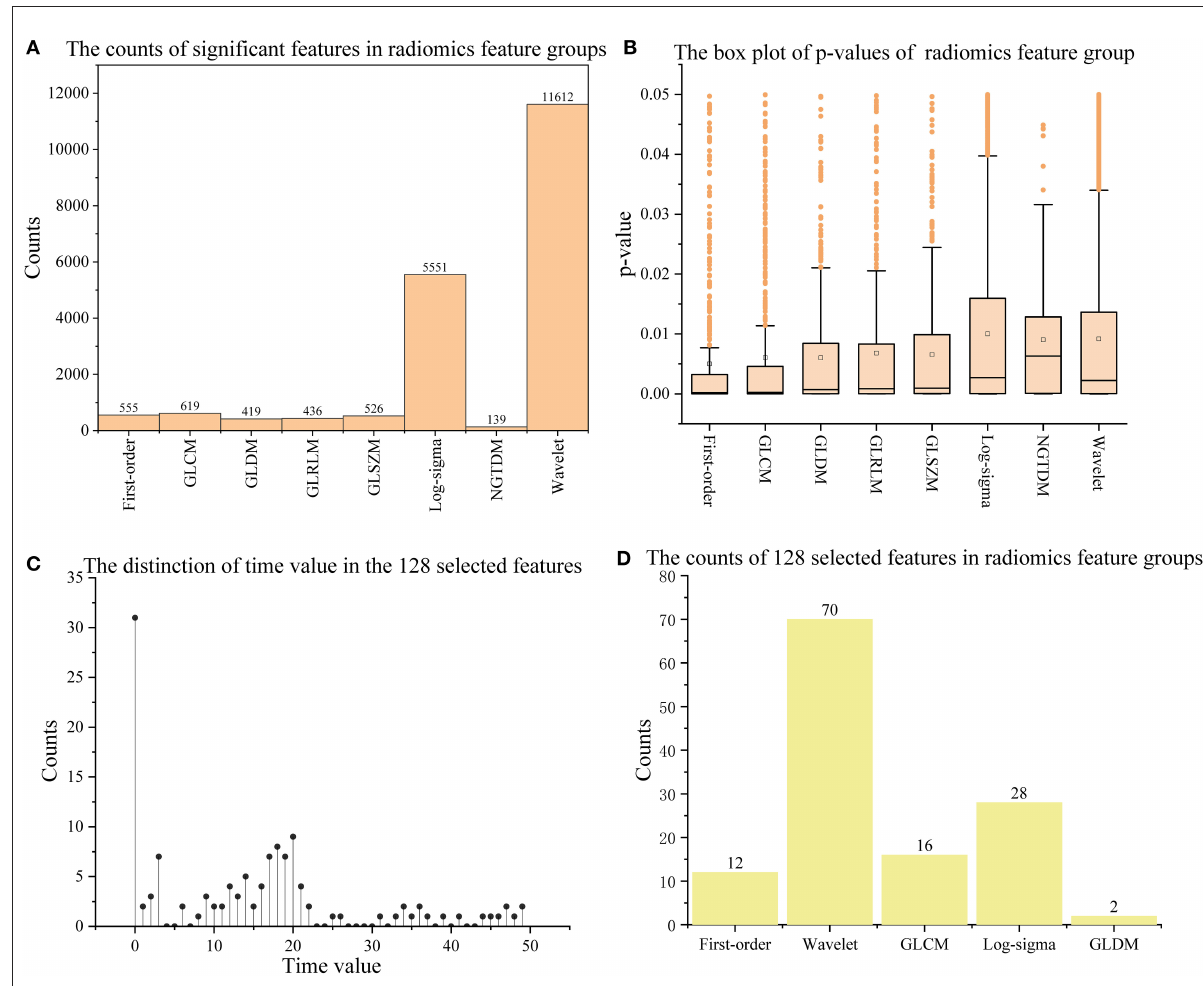
FIGURE2 The information on significant features and 128 outstanding features. (A,B) Show the counts and p- values of significant features in each radiomics feature group; (C,D) show the time values of the 128 selected features and their counts in each radiomics feature group. The orange box in (B) indicates the distribution range of 25–75% p- values; The long horizontal line ’—’ above the box indicates 1.5 times the interquartile range value (1.5 IQR), and the discrete points above the short horizontal line are abnormal points.